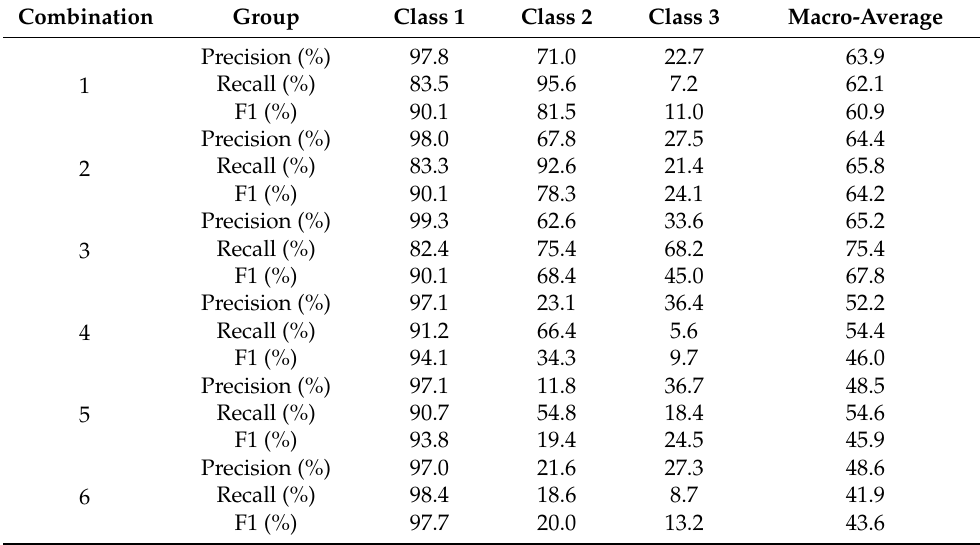
Table 4. Performance of three-class classification problem for six combinations after SMOTE-NC